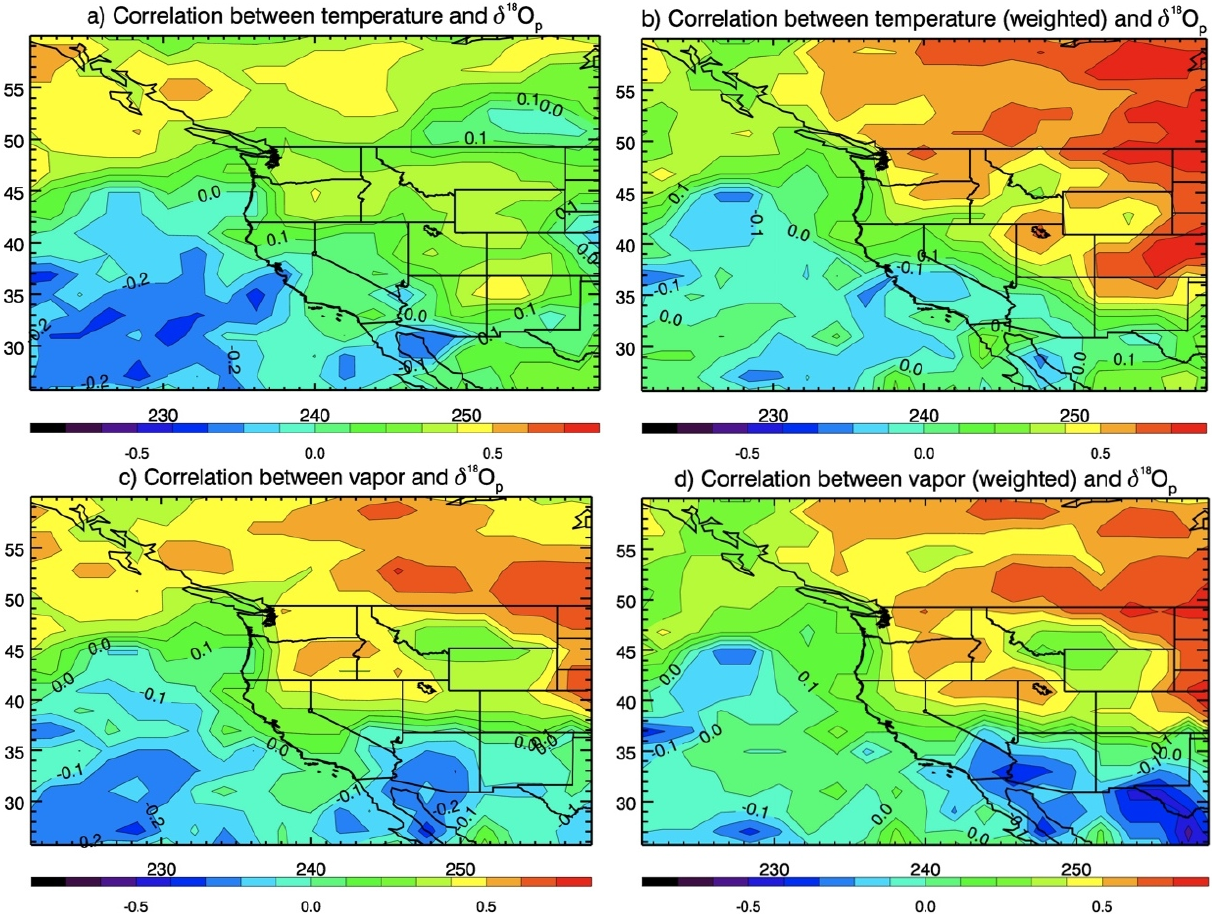
Figure 12. ( a , b ) Correlation between δ 18 O and annual mean temperature; and ( c , d ) surface p level specific humidity (bottom panels). Right panel annual means of temperature and specific humidity were weighted by monthly precipitation. Absolute values of r above 0.263 are significant above the 95% confidence